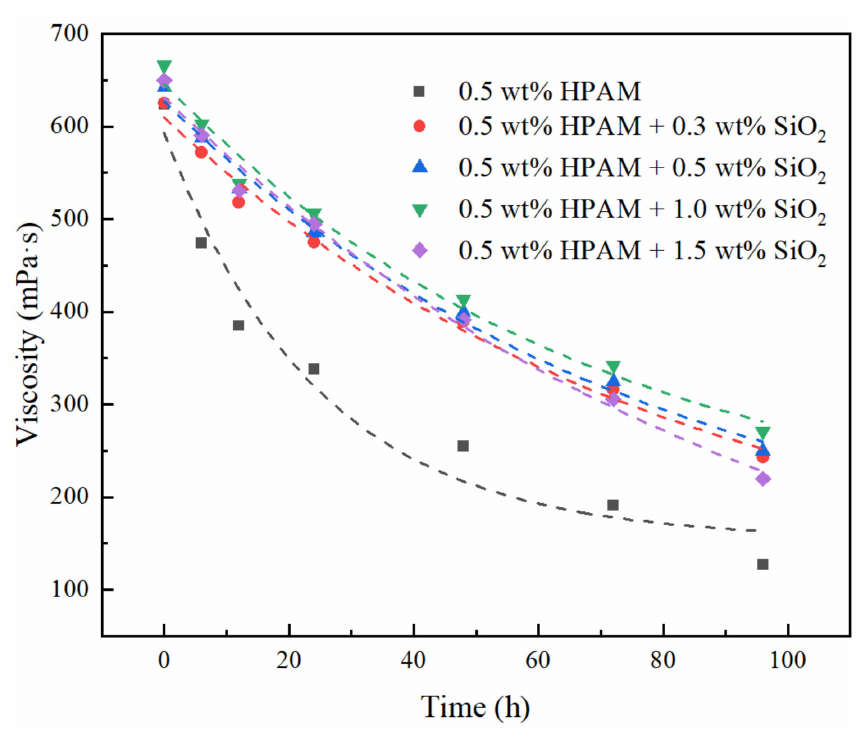
Figure 10. Viscosity of polymer solutions aged at 90 ◦ C for different